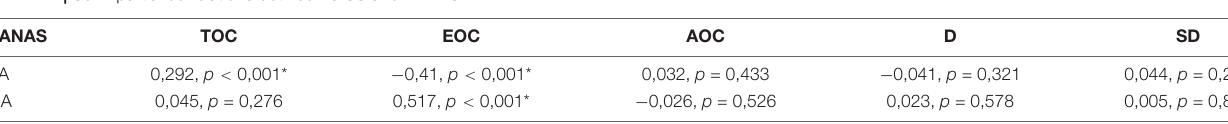
TABLE 4 | Semi-partial correlations between CISS and